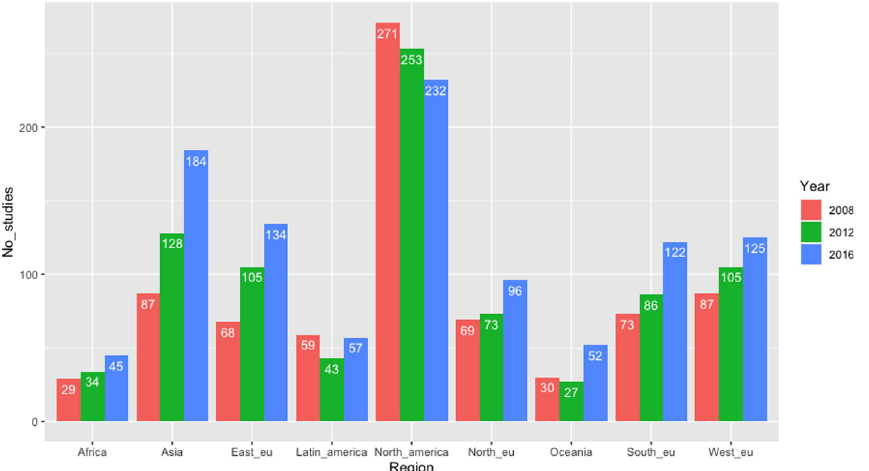
Fig 4. Development of geographic location of clinical trials from 2008–2019.